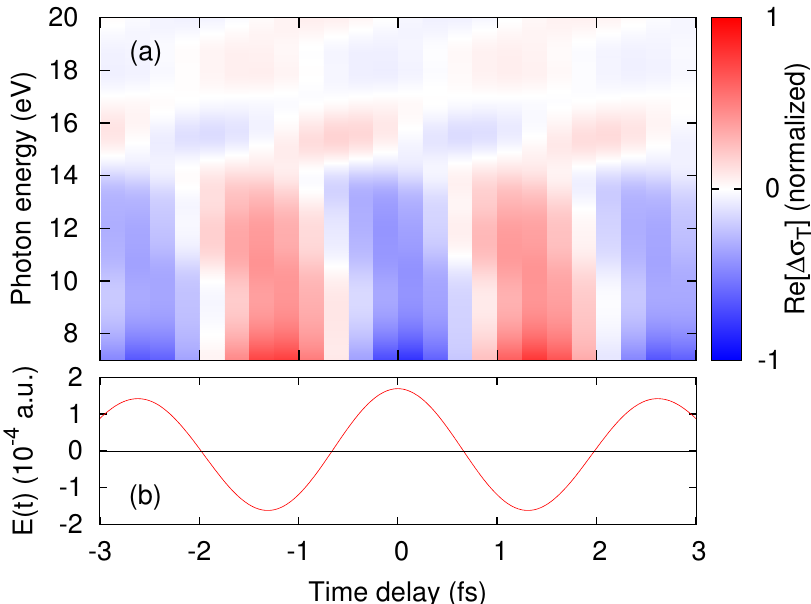
Figure 6. ( a ) real part of the transient conductivity of monolayer h -BN under the IR pump pulse for the y -direction in Figure 1a; ( b ) the time-profile of the applied pump electric field. The result is computed by TDDFT with